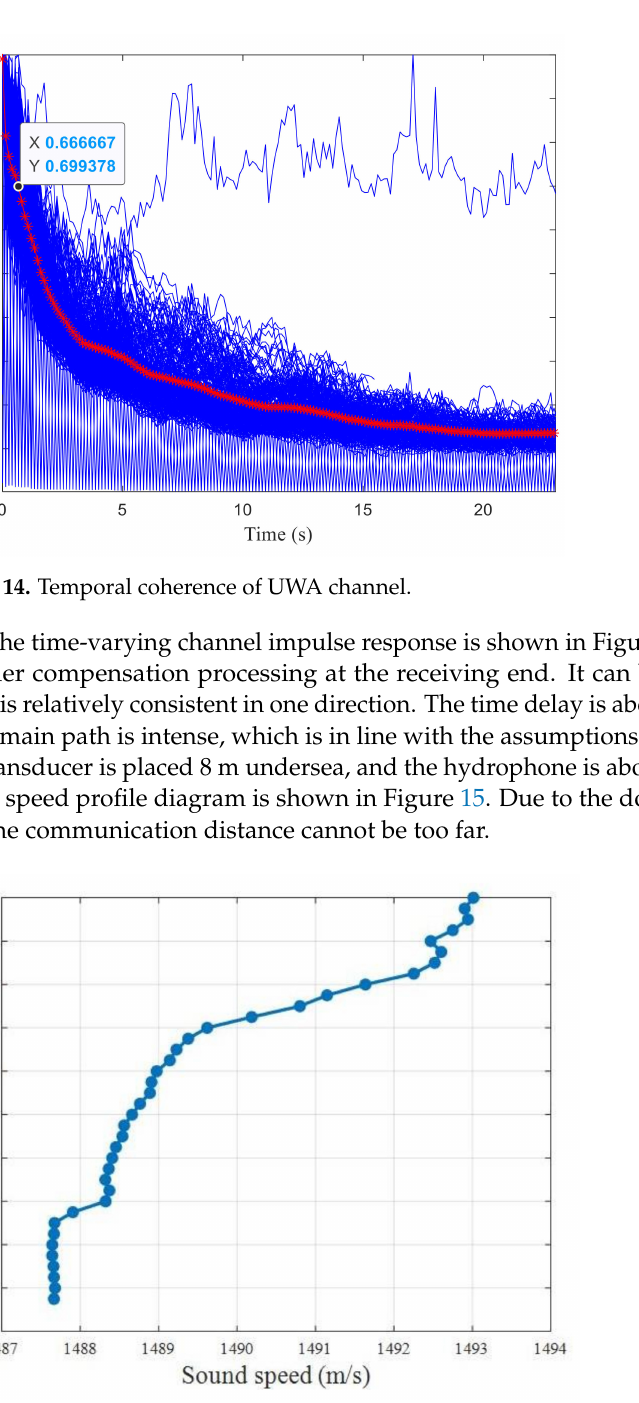
Figure 15. Sound speed profile